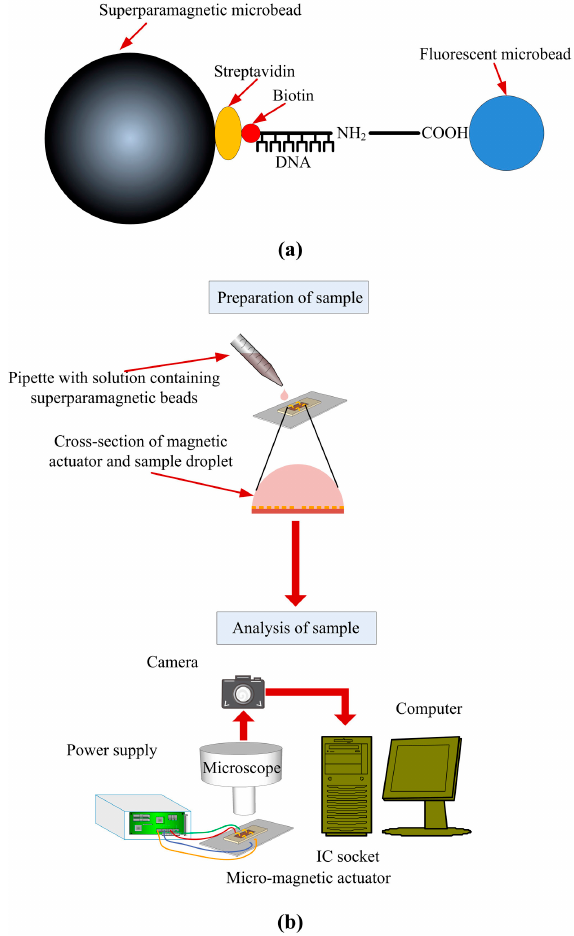
Figure A2. ( a ) Attachment of DNA to a superparamagnetic bead; ( b ) Experimental setup for manipulation of magnetic beads by the magnetic actuator.